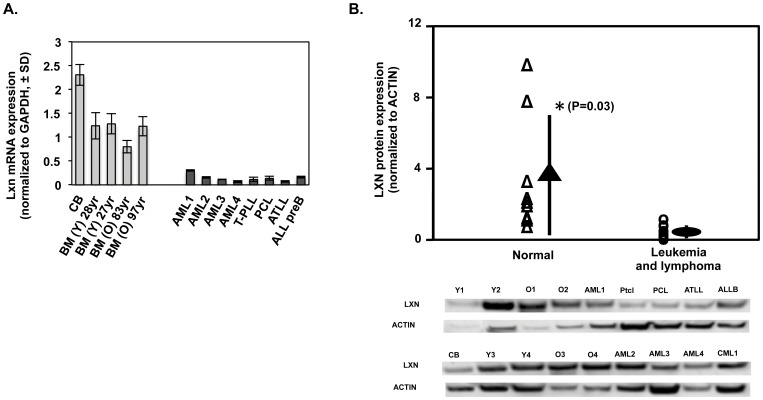
Decreased Lxn expression in stem/progenitor-enriched CD34+ cells in patients with leukemia and lymphoma.(A) Lxn mRNA expression in bone marrow and peripheral blood CD34+ cells from leukemia and lymphoma patients and normal individuals. Lxn mRNA level was measured by quantitative real-time PCR and shown as mean (±1 SD) (n = 12). Normal samples were derived from cord blood (CB), bone marrow (BM) of young at 31 (Y1) and 39 (Y2) years old and old at 85 (O1) and 97 (O2) years old people. The patient samples include acute myeloid leukemia (AML), T cell pro-lympho leukemia (Pctl), plasma cell leukemia (PCL), acute T cell lymphoma (ATLL) and acute lymphoid leukemia (ALL, preB phenotype). (B) LXN protein expression in bone marrow and peripheral blood CD34+ cells from leukemia and lymphoma patients and normal individuals. Western blot was performed on the corresponding samples shown in panel (A) plus five more samples, including two young (Y3 and Y4; at 40 and 31 years old respectively), two old (O3 and O4; at 80 and 87 years old respectively) and chronic myeloid leukemia (CML). The blots (bottom) and their quantification (top) profiles demonstrate the significantly decreased Lxn protein level in leukemic CD34+ and lymphoma cells (P = 0.03).